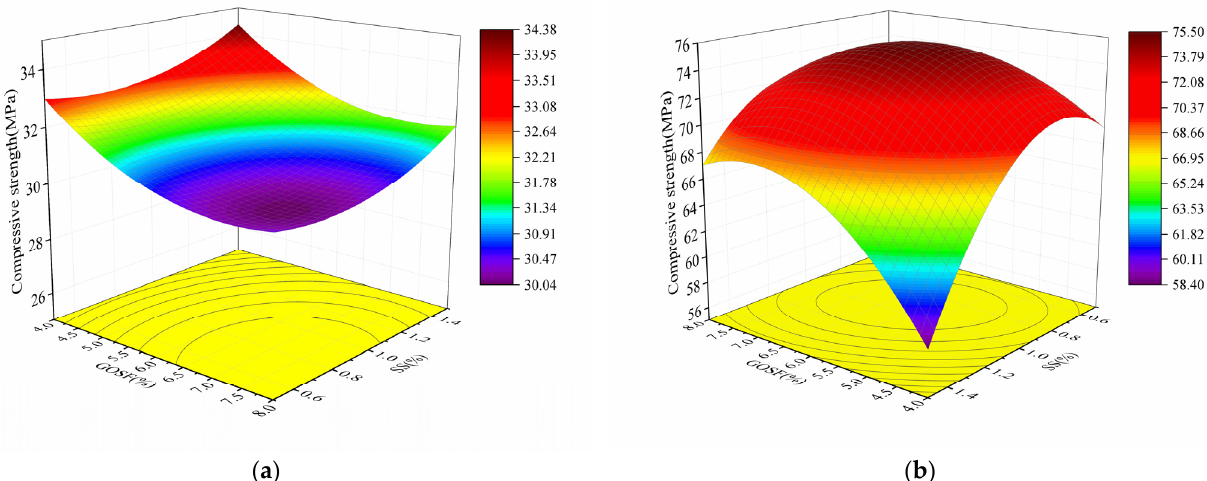
Figure 11. Compressive strength of samples at 3 days ( a ) and 28 days ( b ) vs. the dosages of GOSF and SS.